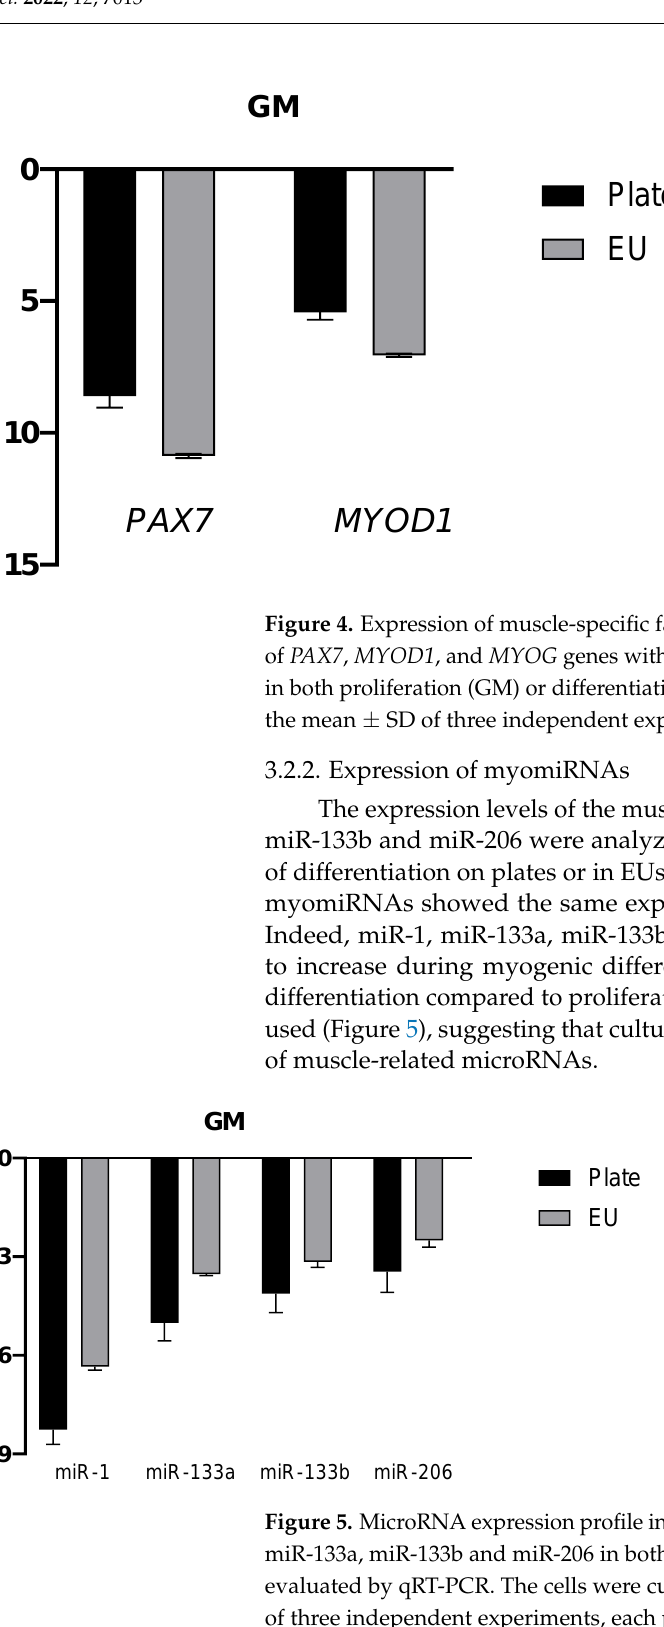
SD of three independent experiments, each performed in triplicate.